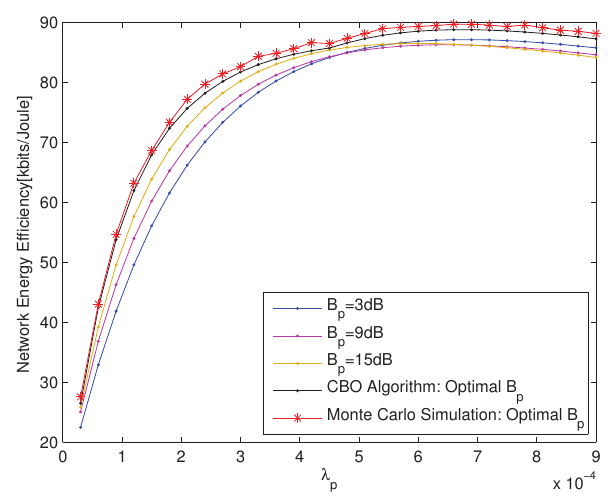
Figure 2. The network EE versus λ p with λ u = 0.0018.